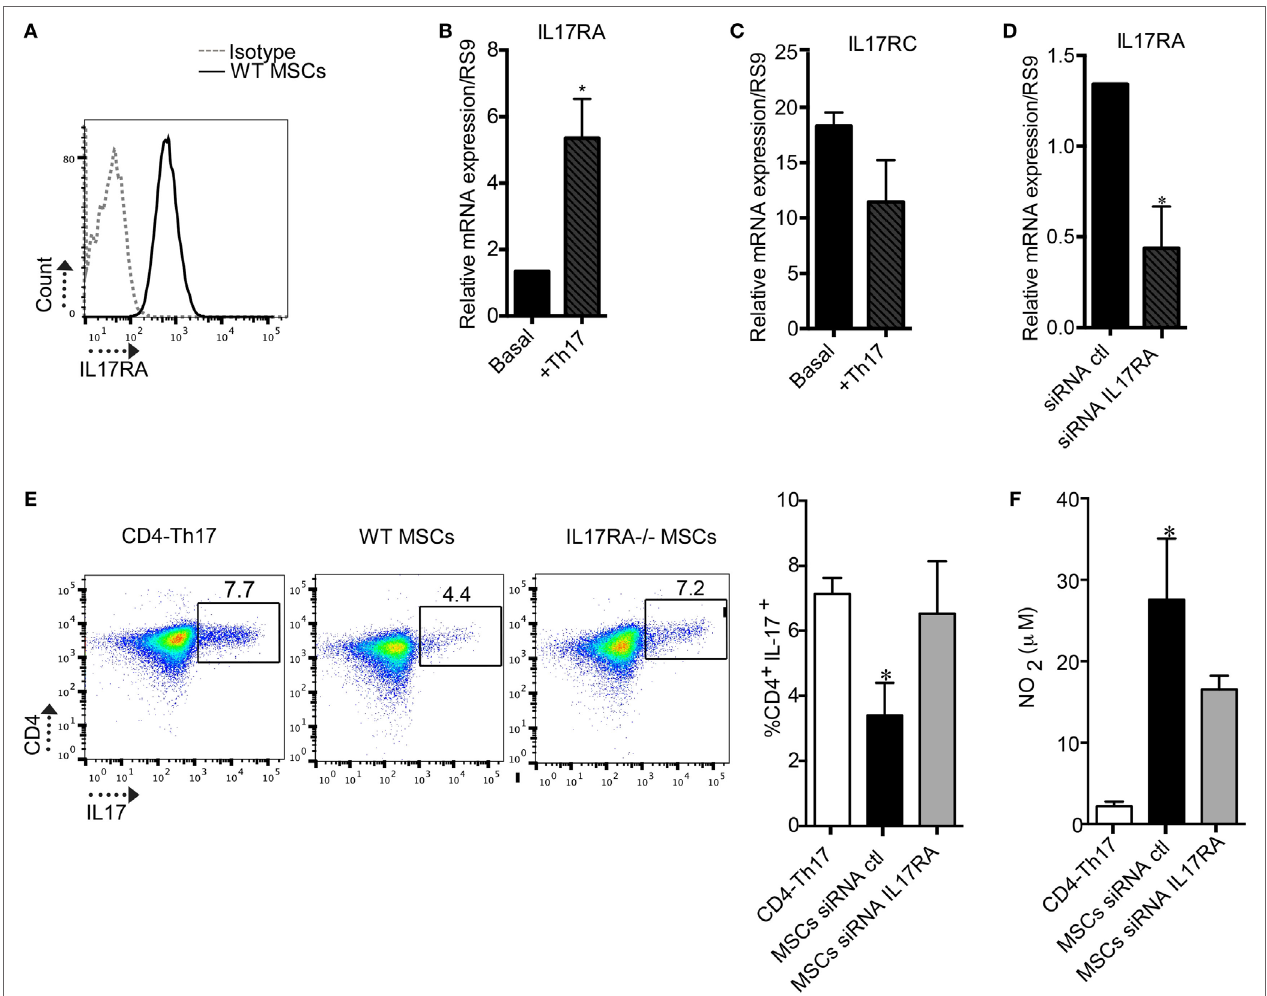
FigUre 1 | The expression of the IL17RA subunit is critical for mesenchymal stem cells (MSCs)-suppressive effect on Th17 cells . (a) Representative histogram of the IL17RA subunit expression in MSCs obtained by FACS. (B,c) Quantification of the expression levels of IL17RA and IL17RC subunits in MSCs cultured without or with Th17 cells by quantitative real-time PCR (qRT-PCR). (D) Quantification of IL17RA expression level in MSCs after transfection with siRNA control (siRNA ctl) or a siRNA targeting IL17RA (siRNA IL17RA) by qRT-PCR. (e) Representative dot plot of CD4 + IL17 + cells (CD4-Th17) analyzed by FACS. Analysis of the percentage of Th17 cells when CD4 + T cells undergoing Th17 polarization were cultured alone or with MSCs transfected with either siRNA ctl or siRNA IL17RA during 5 days. (F) Quantification of NO 2 production in the supernatant of Th17 cells cultured alone or with either MSCs siRNA ctl or MSCs siRNA IL17RA. Bars in the plots represent the mean ± SD of n = 4 different mice. Statistical differences on cocultures were calculated using the Kruskal–Wallis test. * P < 0.05, ** P < 0.005 and for PCR Mann–Whitney test was